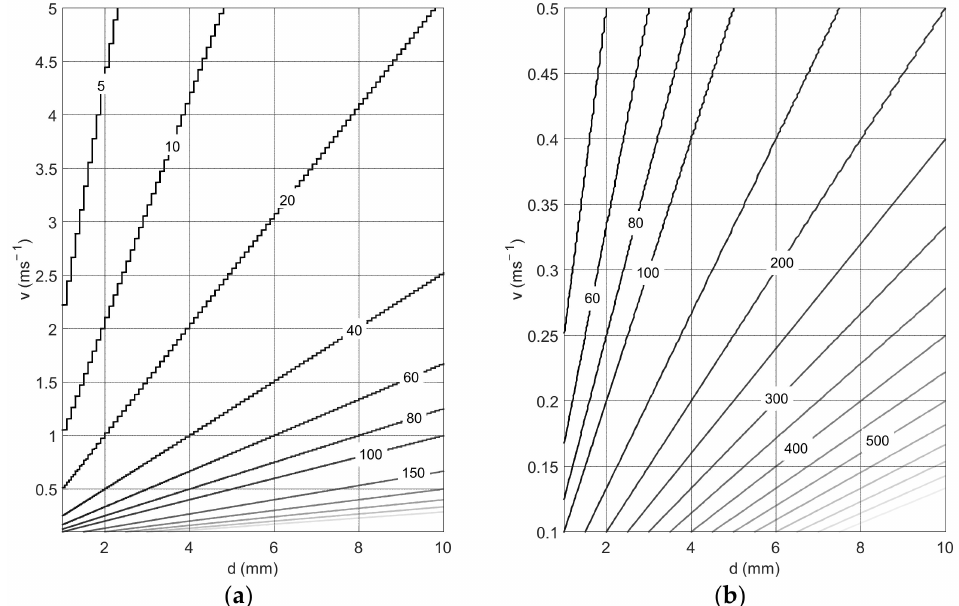
Figure 3. The value of the shift of the correlation maximum depending on the distance d between the wires and on the flow velocity v , for a sampling frequency of 10 kHz and velocity in the range ( a ) 0.1 to 5 ms − 1 and ( b ) 0.1 to 0.5 ms − 1 .